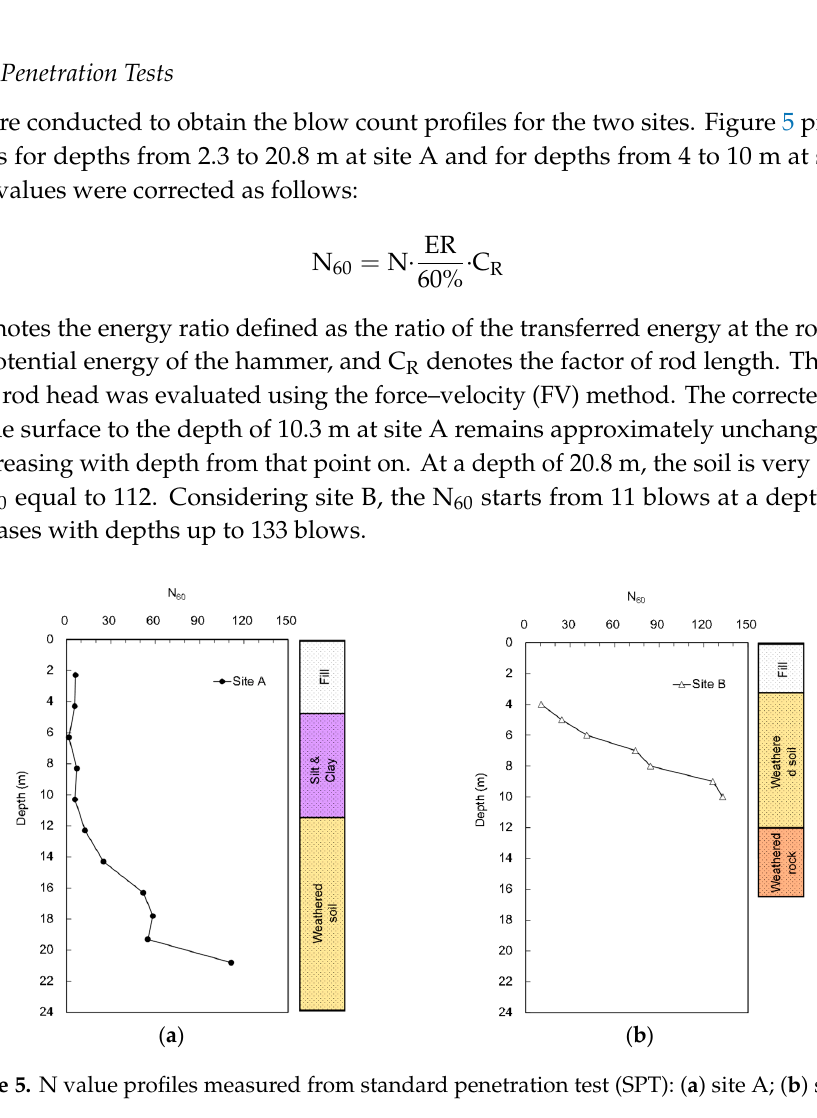
Figure 4. Location of sites and layout of the soundings in South Korea. BH—borehole.